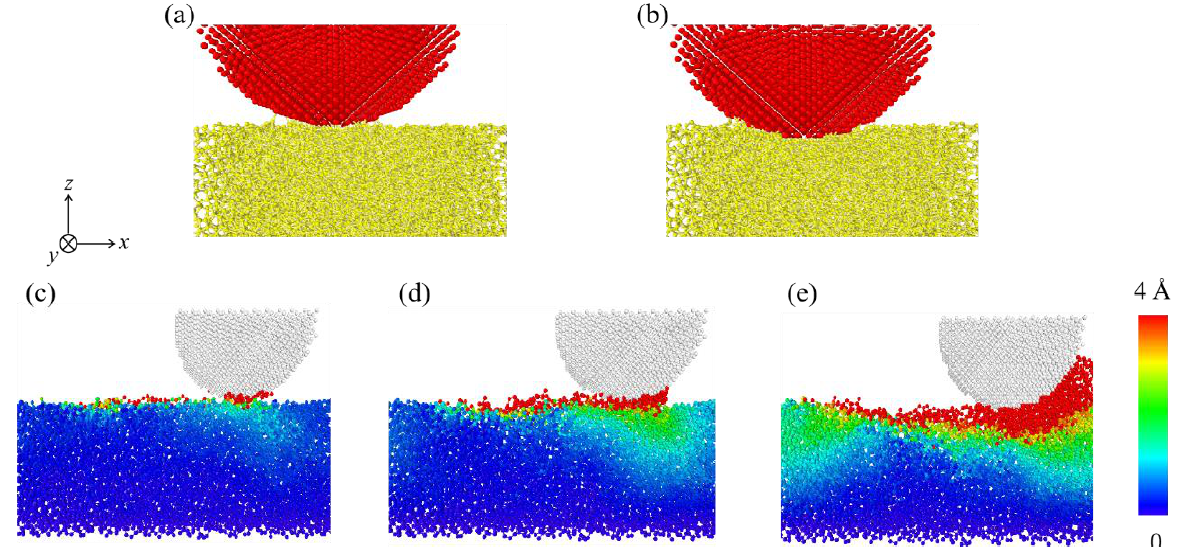
Figure 7. The contact configuration between the DLC film and the diamond slider with ( a ) F n = 78 nN and ( b ) F n = 588 nN when L = 0; contour of atom displacement with ( c ) F n = 78 nN, ( d ) F n = 392 nN, and ( e ) F n = 588 nN when L = 50 Å. The color of the atom indicates its displacement distance.